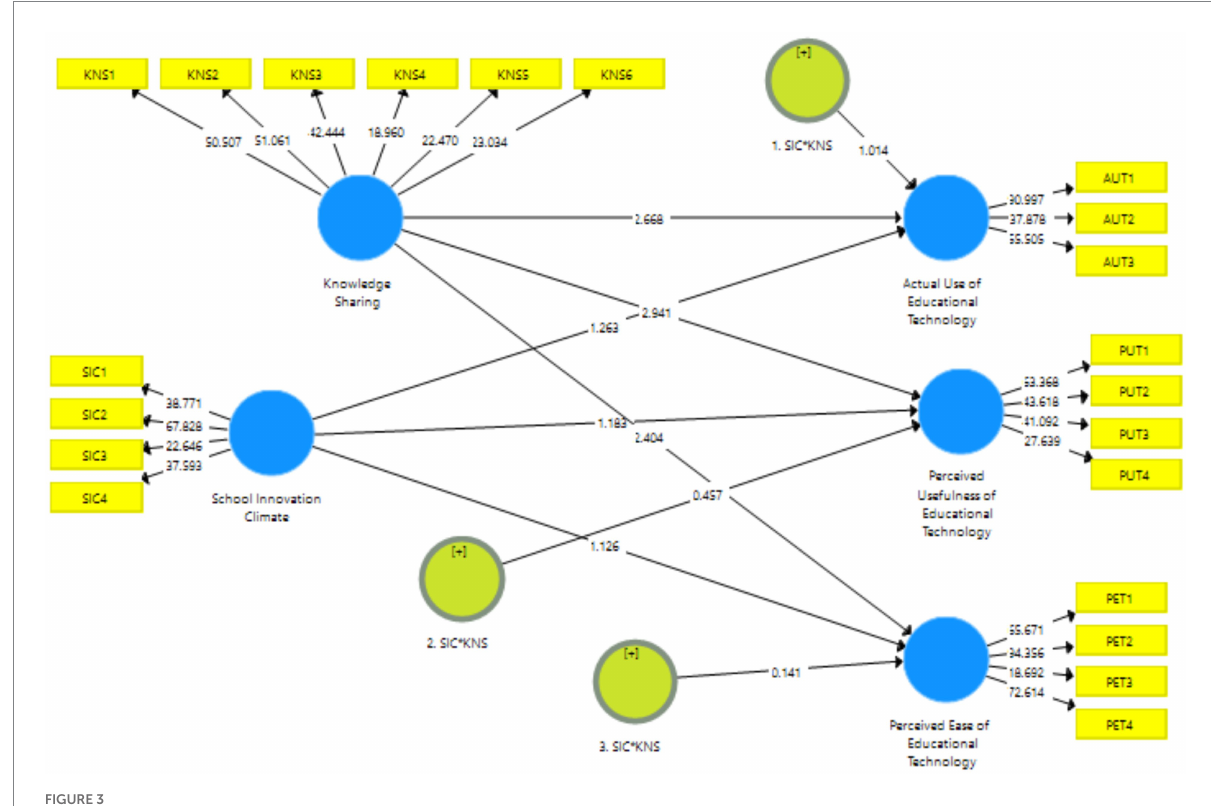
FIGURE 3 Structural model